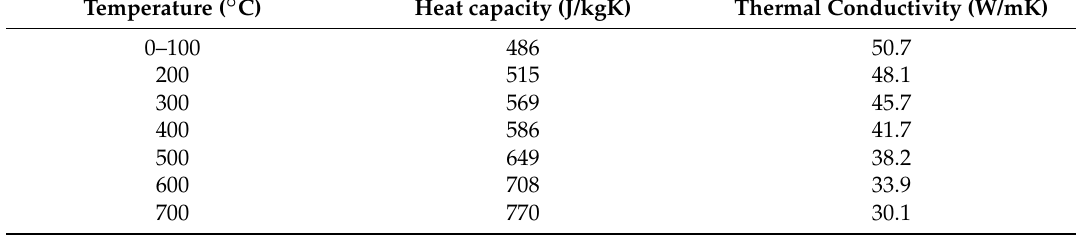
Table 2. Thermal properties of AISI 1040.